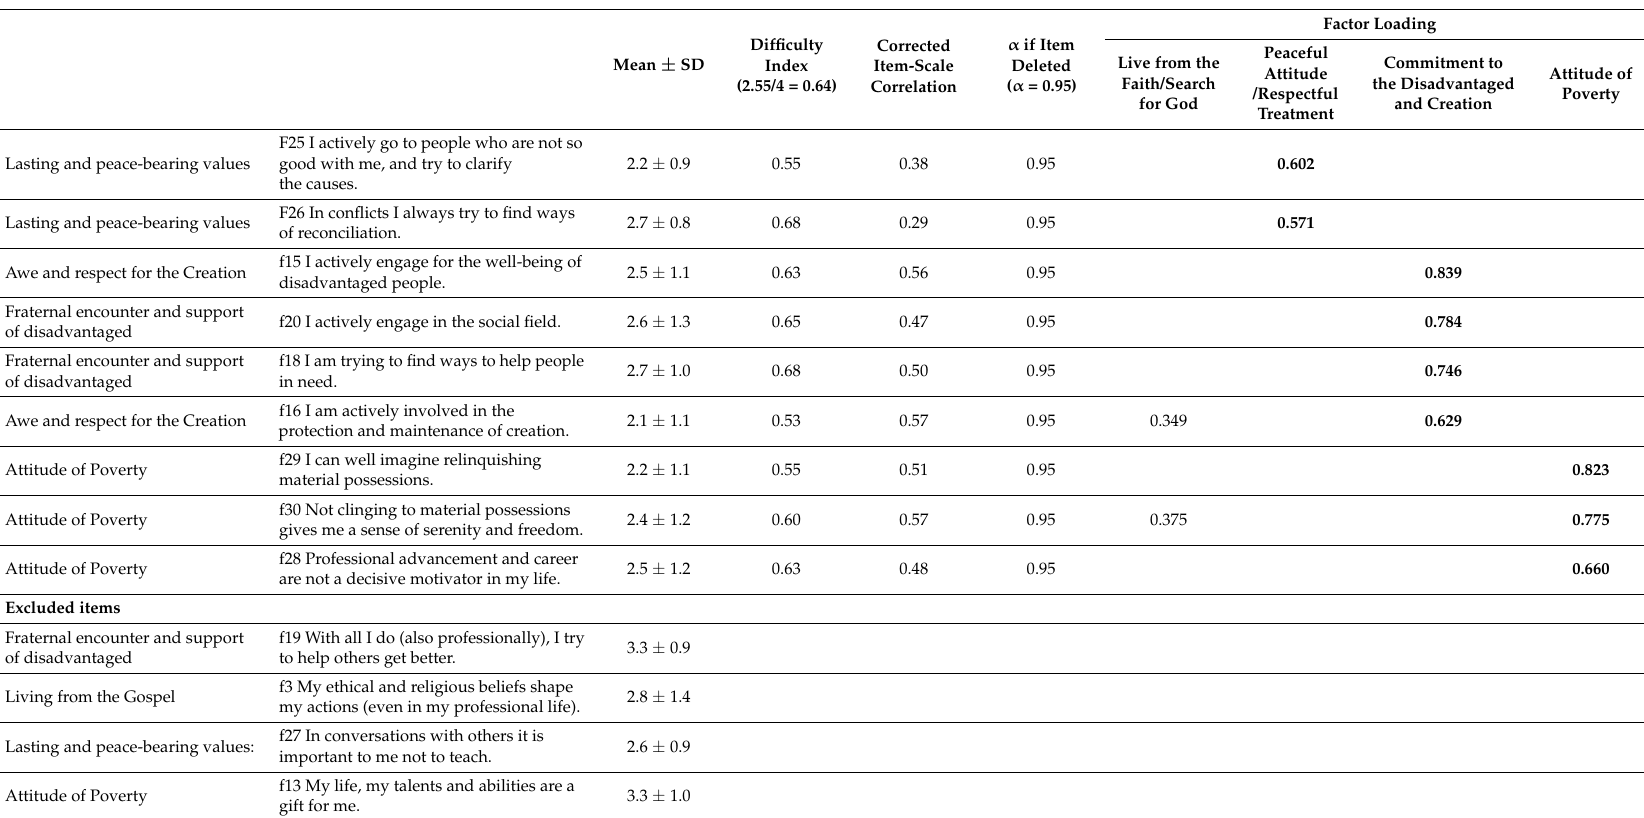
Table 2. Reliability and factorial